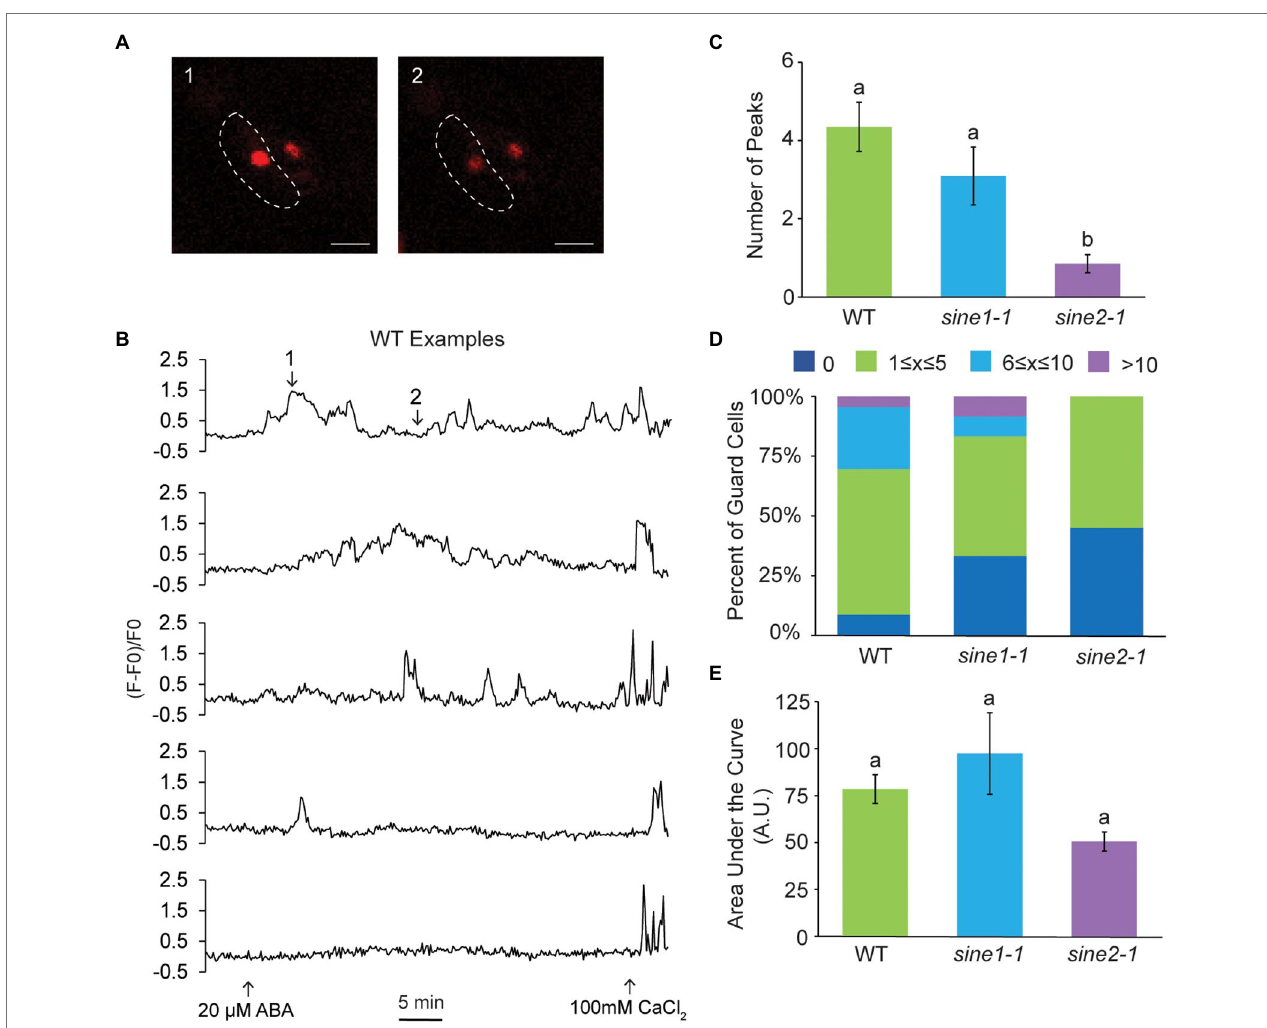
FIGURE 5 | Nuclear calcium fluctuations are disrupted in sine2-1 . (A) Representative images of nuclear Ca 2+ fluctuations in WT after addition of 20 μ M ABA. Images shown are of the guard cell nuclei at two individual time points. The border of the left guard cell is outlined with the dotted line. Scale bars = 10 μ m. (B) Five examples of nuclear Ca 2+ fluctuations in WT in response to 20 μ M ABA, presented as normalized fluorescence intensity over time. Numbers in the first graph correspond to the image numbers in (A) . (C) Number of peaks observed after addition of ABA in WT, sine1-1 , and sine2-1 guard cells. Statistical significance was calculated using one-way ANOVA followed by a post-hoc Tukey HSD test. Lowercase letters denote groups that are statistically different ( p < 0.01). (D) Number of peaks observed were grouped into several categories for WT, sine1-1 , and sine2-1 . (E) Area under the curve of nuclear Ca 2+ fluctuations in WT, sine1-1 , and sine2-1 after treatment with 20 μ M ABA. Statistical significance was calculated using one-way ANOVA followed by a post-hoc Tukey HSD test. Lowercase letters denote groups that are statistically different ( p <